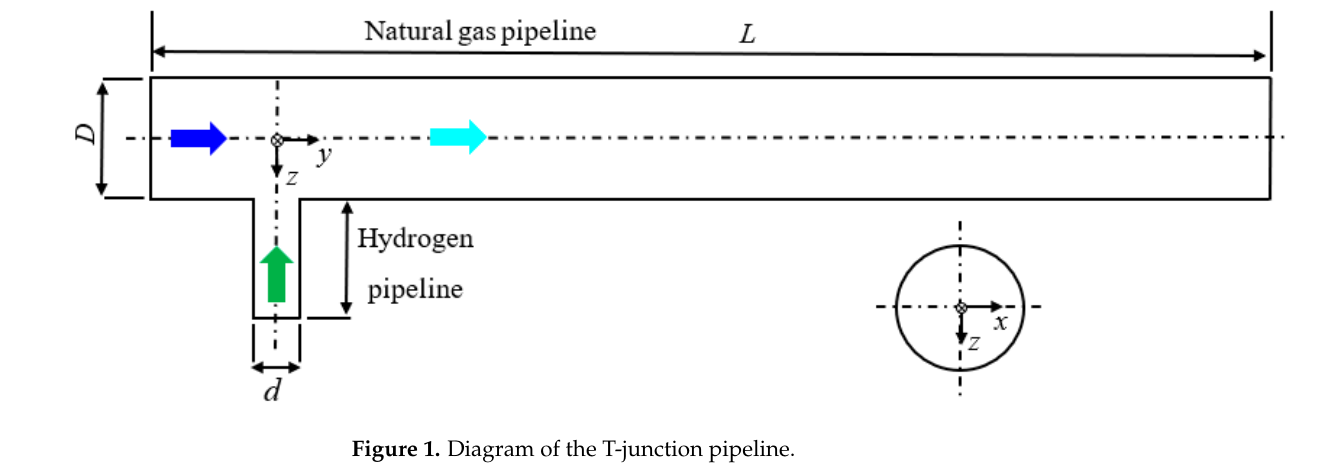
Figure 1. Diagram of the T-junction pipeline.